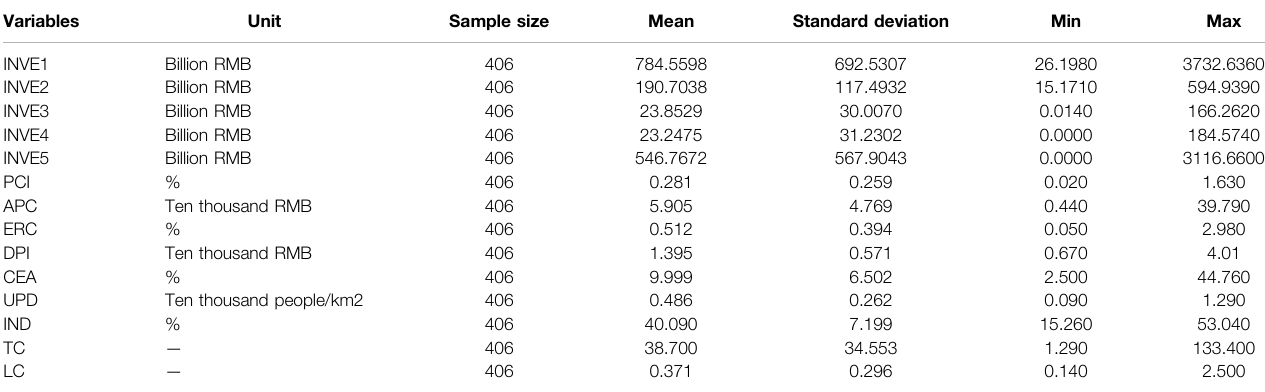
TABLE 1 | Descriptive statistics of variables. Variables